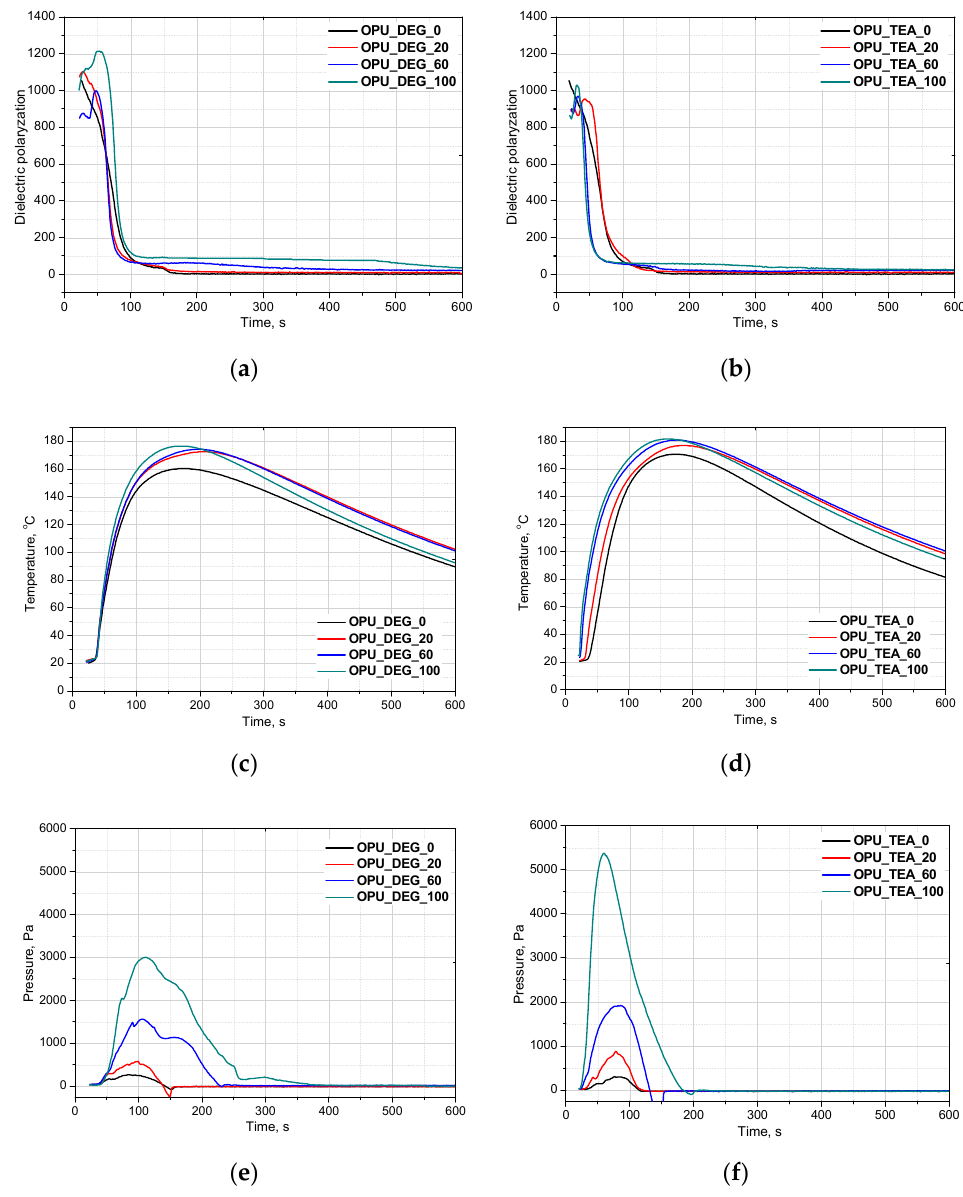
Figure 2. Bio-polyols UCO_DEG and UCO_TEA with different contents and their influence on on dielectric polarization ( a , b ), temperature ( c , d ) and pressure ( e , f ) of reaction mixtures.